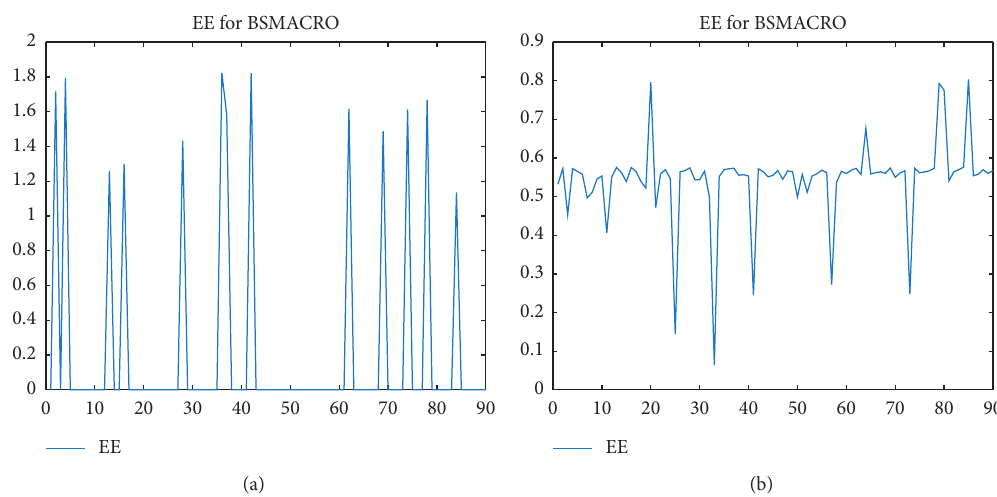
Figure 8: The energy efficiency (a) and SINR (b) of macro BS for 90